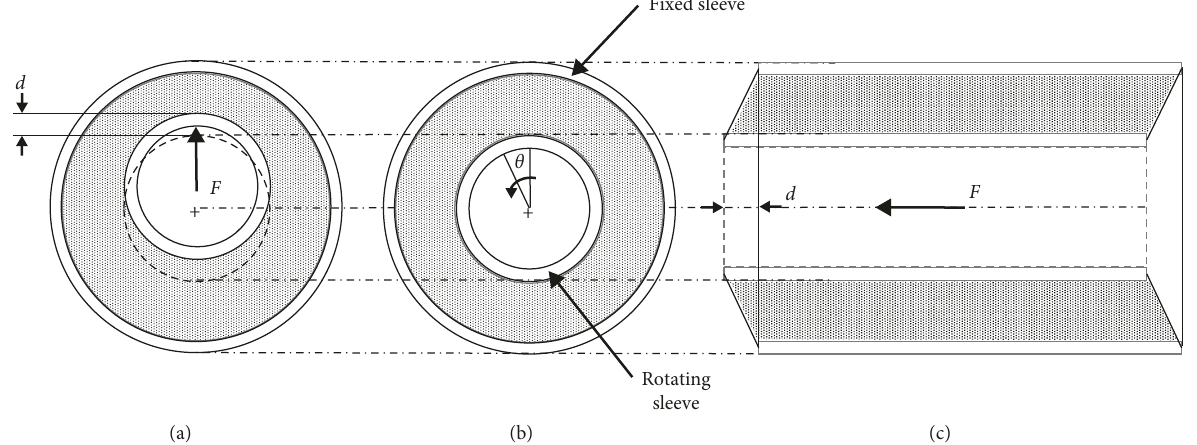
Figure 1: Typical modes of deflection in an automotive bushing: (a) radial, (b) torsional, and (c) axial.